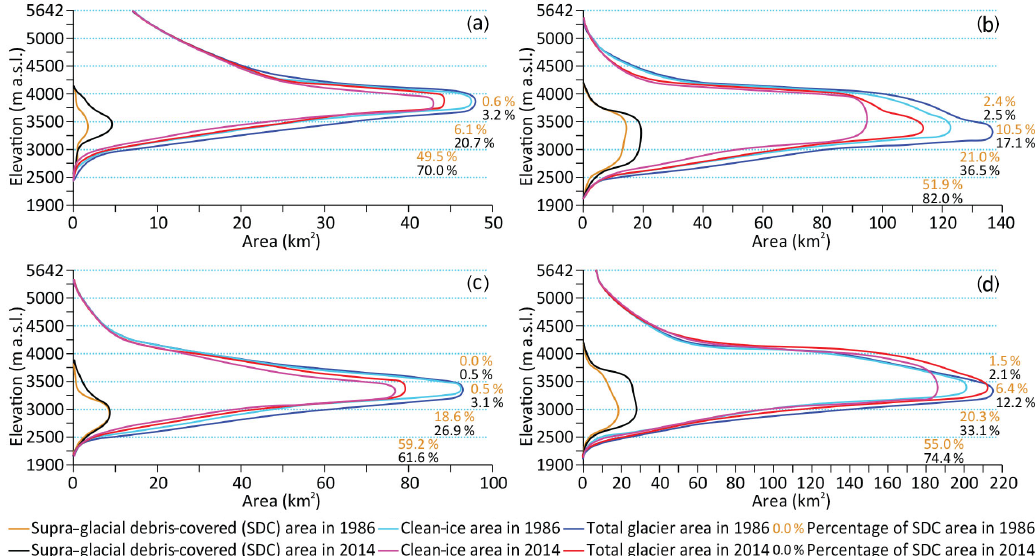
Figure 6. Hypsometry of supra-glacial debris cover, clean ice and total glacier area of the four study regions in 1986 and 2014. (a) Elbrus, (b) northern slope of the Greater Caucasus, (c) southern slope of the Greater Caucasus and (d) all selected glaciers. Supra-glacial debris cover percentage is given according to the different elevation zones in 1986 (brown digits) and 2014 (black